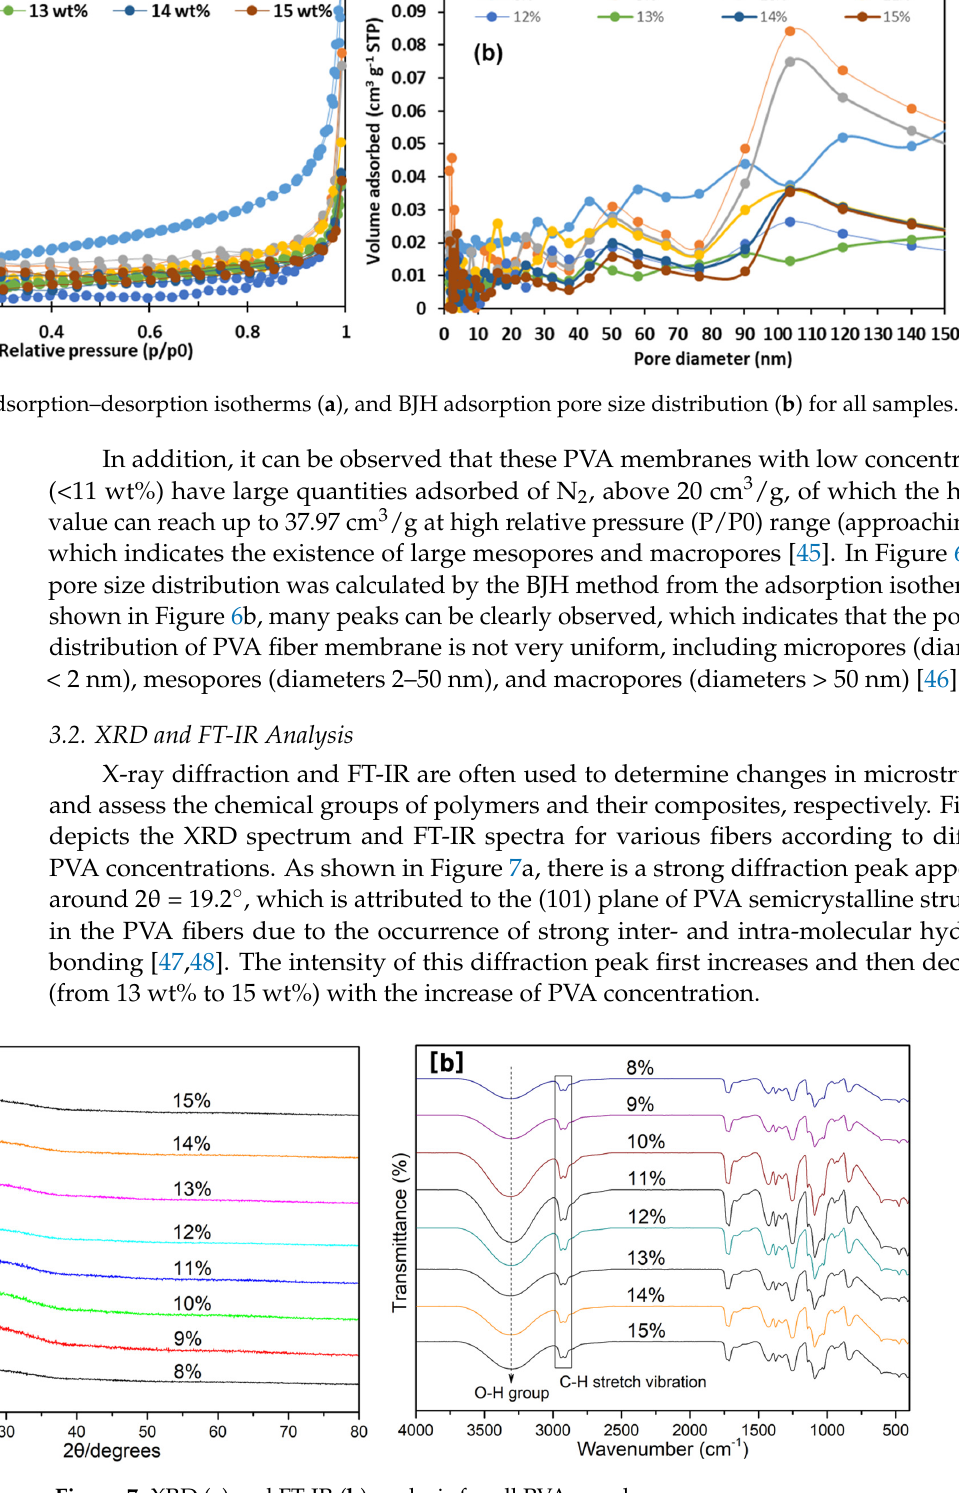
9 of 16 Figure 5. Bio-TEM images of PVA fibers with various PVA solution concentrations: ( a ) 8 wt%, ( b ) 9 wt%, ( c ) 10 wt%, ( d ) 11 wt%, ( e ) 12 wt%, ( f ) 13 wt%, ( g ) 14 wt%, and ( h ) 15 wt%. Figure 6 shows the nitrogen (N 2 ) adsorption and desorption isotherm and Barret– Joyner–Halender (BJH) pore size distribution. The N 2 adsorption-desorption method and BJH are common methods to investigate the pore structure and pore size distribution for fiber membrane materials. The pore structure characteristics of PVA nanofibrous mem- branes were obtained by the N 2 adsorption-desorption measurements at 77 K. In Figure 6a, the adsorption isotherms of PVA membranes combine type I and type II characteristics, as there is a weak hystersis loop between the adsorption and desorption branches. In addition, it can be observed that these PVA membranes with low concentrations